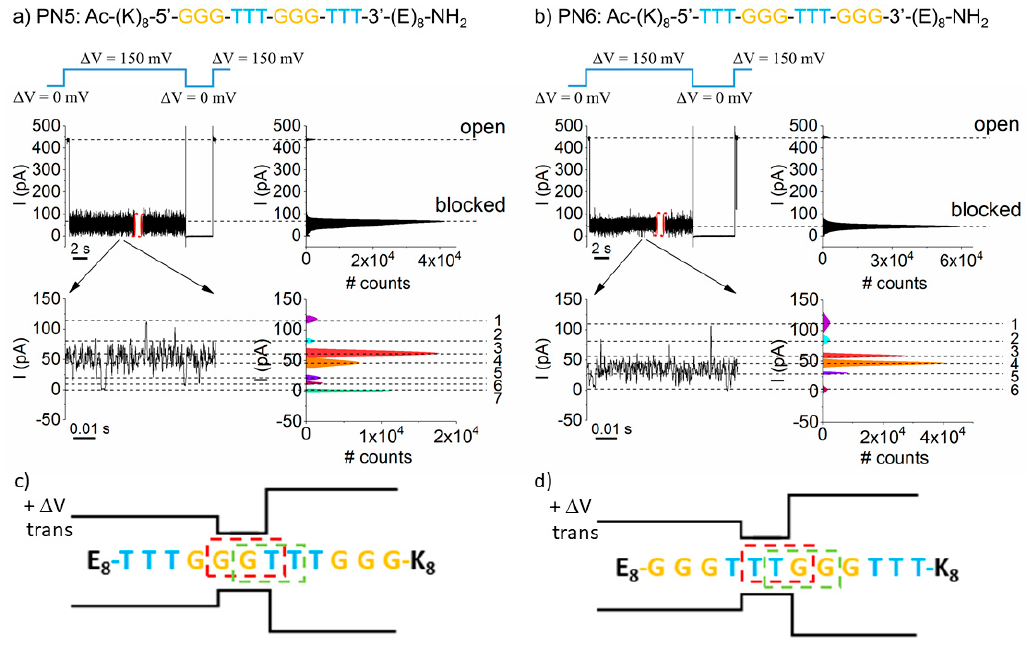
Figure 3. The influence of the PNAs’ primary structure on the ionic current fluctuations. Representative current recordings through a single α -HL nanopore clamped at ∆ V = + 150 mV displaying the transient pore blockades by ( a ) PN5 (K 8 –G 3 –T 3 –G 3 –T 3 –E 8 ) and ( b ) PN6 (K 8 –T 3 –G 3 –T 3 –G 3 –E 8 ) PNAs added to the trans side of the lipid membrane [9 μ M], in an electrolyte containing 3 M KCl and 10 mM HEPES, pH = 7.4. The additional fluctuations of the residual ionic current are presented in the zoomed-in excerpts, together with the corresponding all-points histograms showing the amplitude distribution of the blockade substates. The sketches in ( c ) and ( d ) help to illustrate the orientation of the distinct triplet bases from the PN5 and PN6 constructs most likely occluding the α -HL’s constriction region during the meta-stable capture events (see text). The drawn α -HL displaying the α -barrel ( trans side), constriction region, and vestibule opening is not shown to scale.